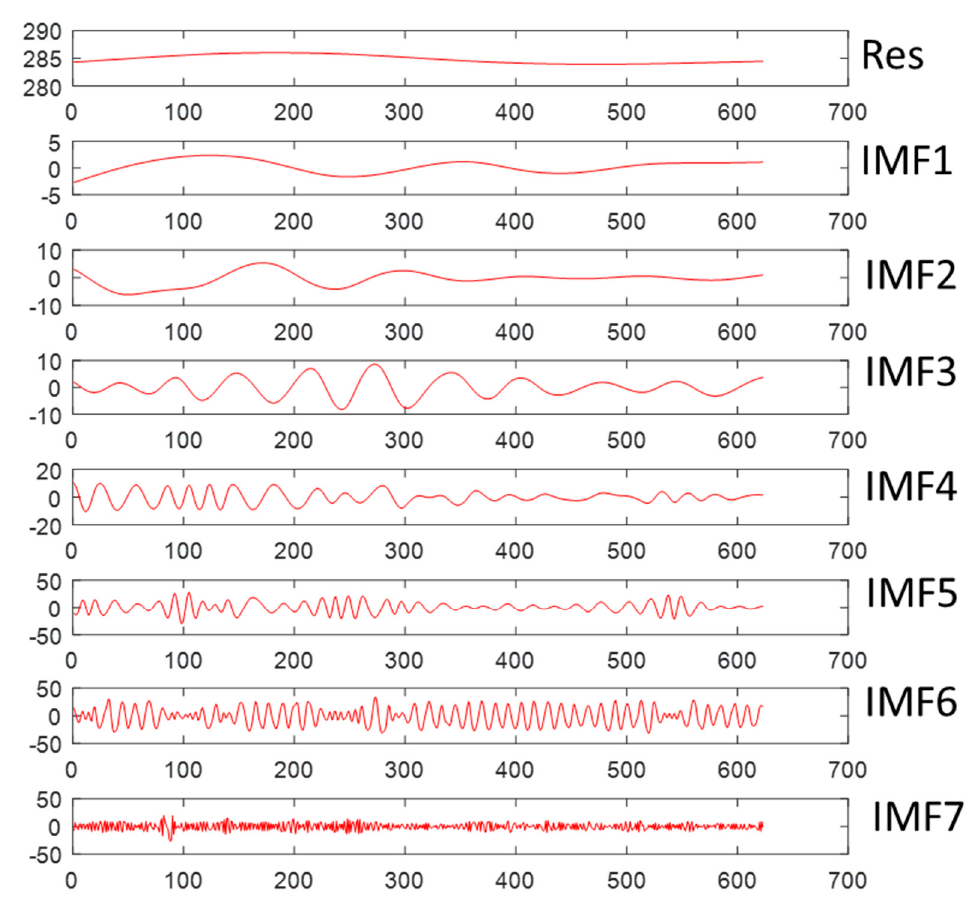
Figure 5. Modes extracted by empirical mode decomposition (EMD) for OCBA TOC ozone time series.